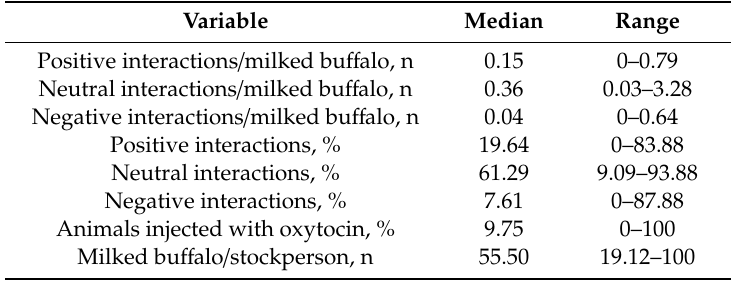
Table 3. Median and range of the variables observed on the stockpeople (n = 27).